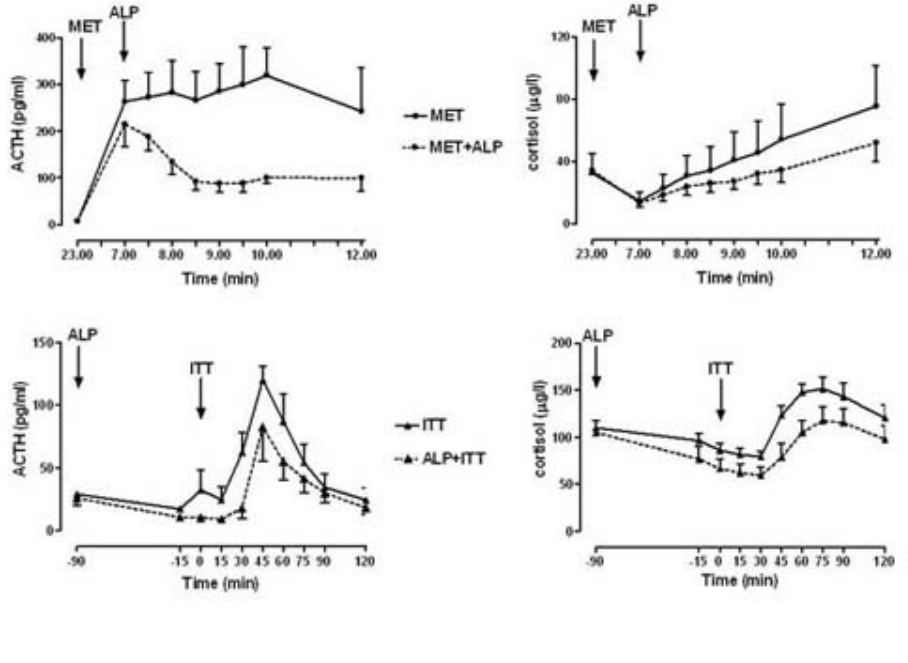
FIGURE 1. ACTH and cortisol levels (mean ± SEM) after metyrapone (MET, 0.04 g/kg p.o. at 2300 h on the previous night), MET + alprazolam (ALP, 0.02 mg/kg p.o. at –90 min), ITT (regular insulin, 0.1 U/kg i.v. at 0 min), or ITT + ALP in normal